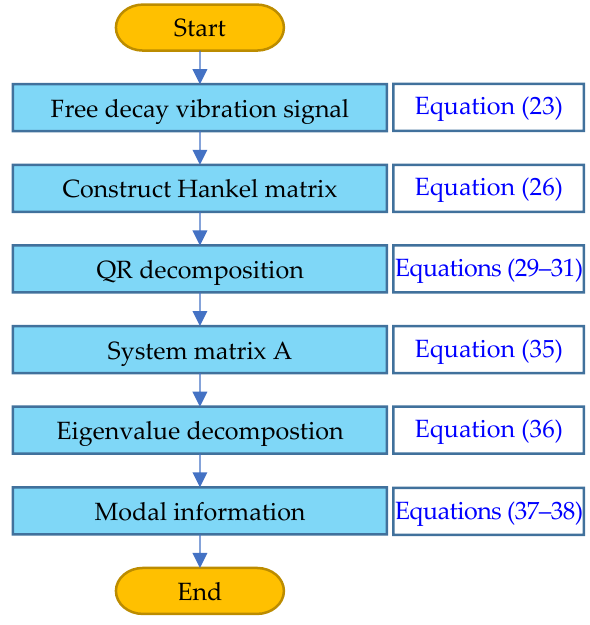
Figure 3. The SSI process.